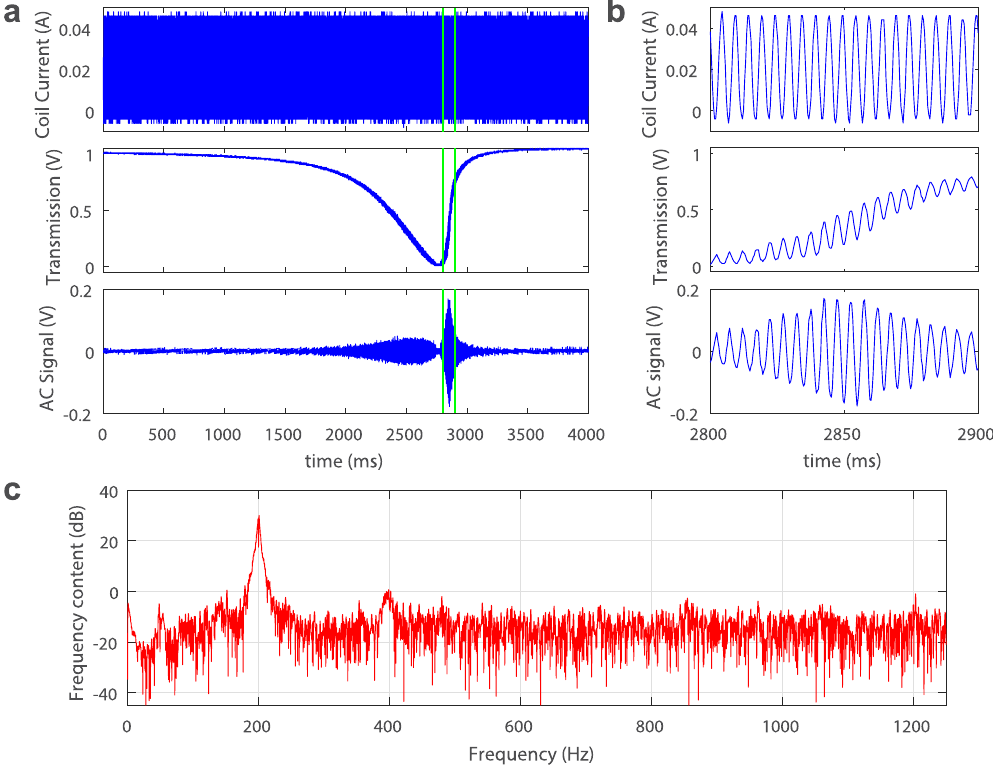
Figure 2. Experimental results. ( a ) Response of the optical resonance to the varying magnetic fields. Upper panel: driving current of the magnetic coil; Middle panel: optical resonance mode showing thermal heating effect caused by the probe laser (triangular lineshape), and overlaying oscillating signal in response to the magnetic field; Lower panel: time varying components of the optical resonance signal in the middle panel. ( b ) Detailed view of the data between the two green lines in ( a ). ( c ) Power spectrum of the signal in the lower panel of ( a ) between time 2 s and 3